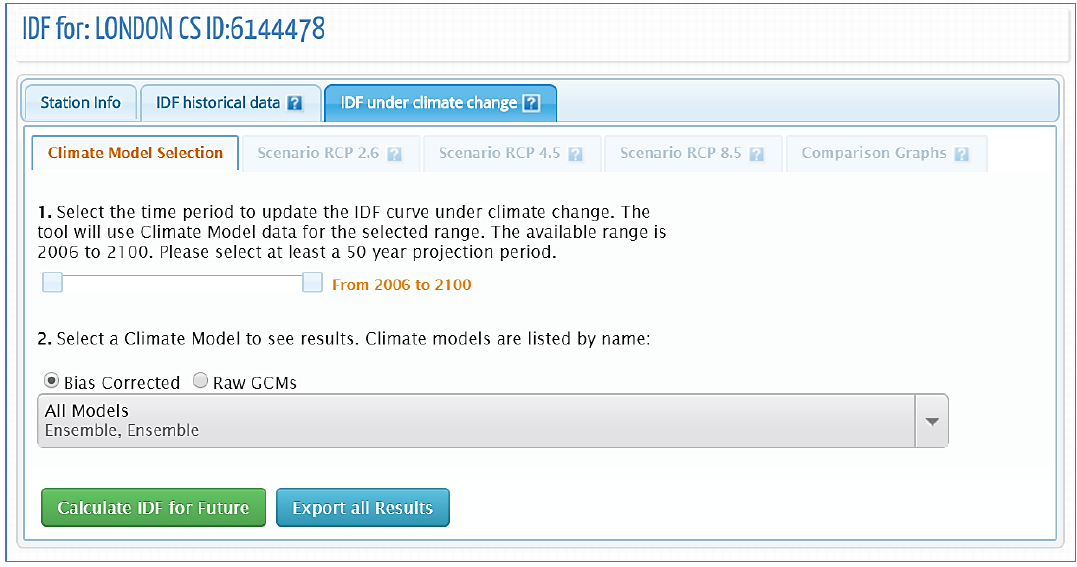
Figure 13. Screen for selection of the Global Climate Models (GCM) model and time period.